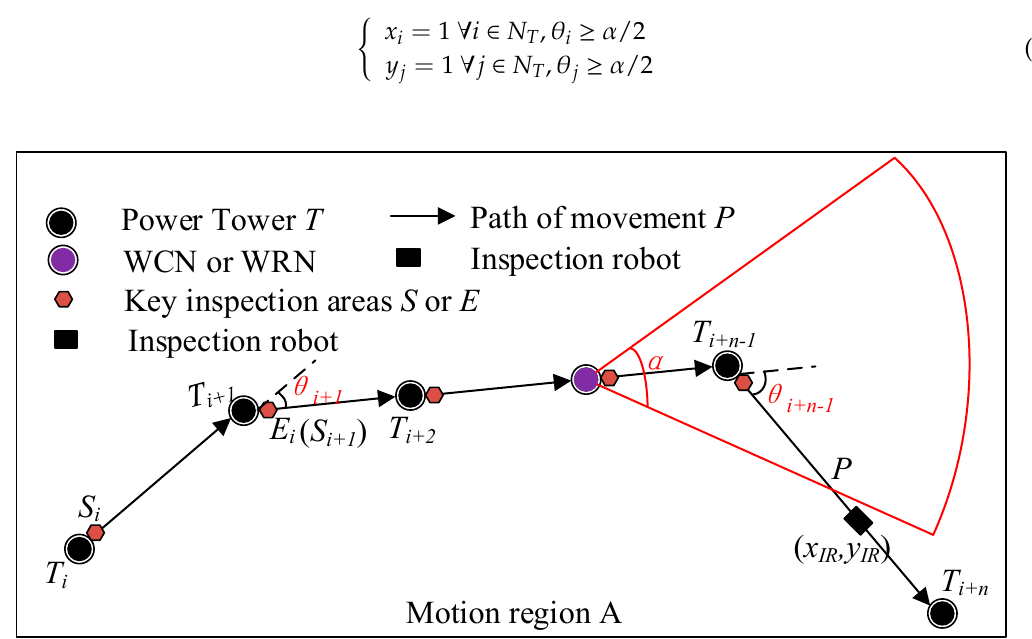
Figure 7. E ff ective coverage area of the linear wireless Figure 7. Effective coverage area of the linear wireless signal.